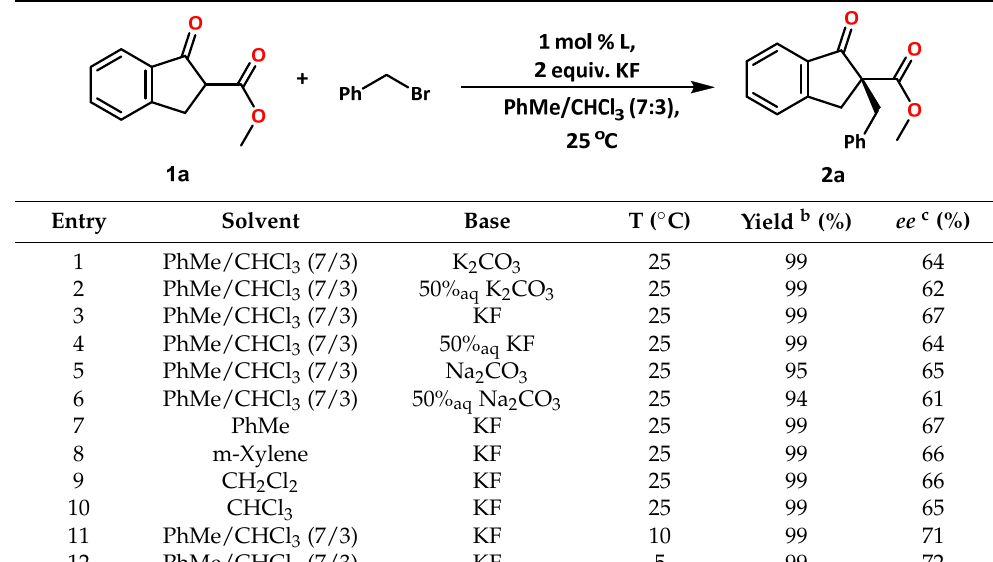
Table 1. Optimization of the reaction conditions for the alkylation of β -keto ester 1a with phase- transfer catalyst L a .